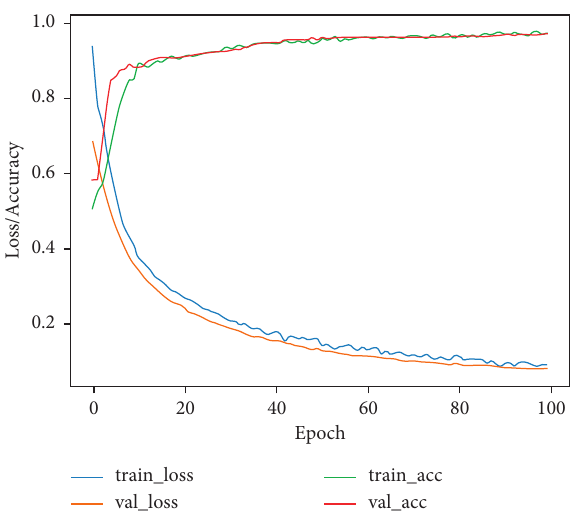
Figure 6: Accuracy and loss for COVID-19 detection.